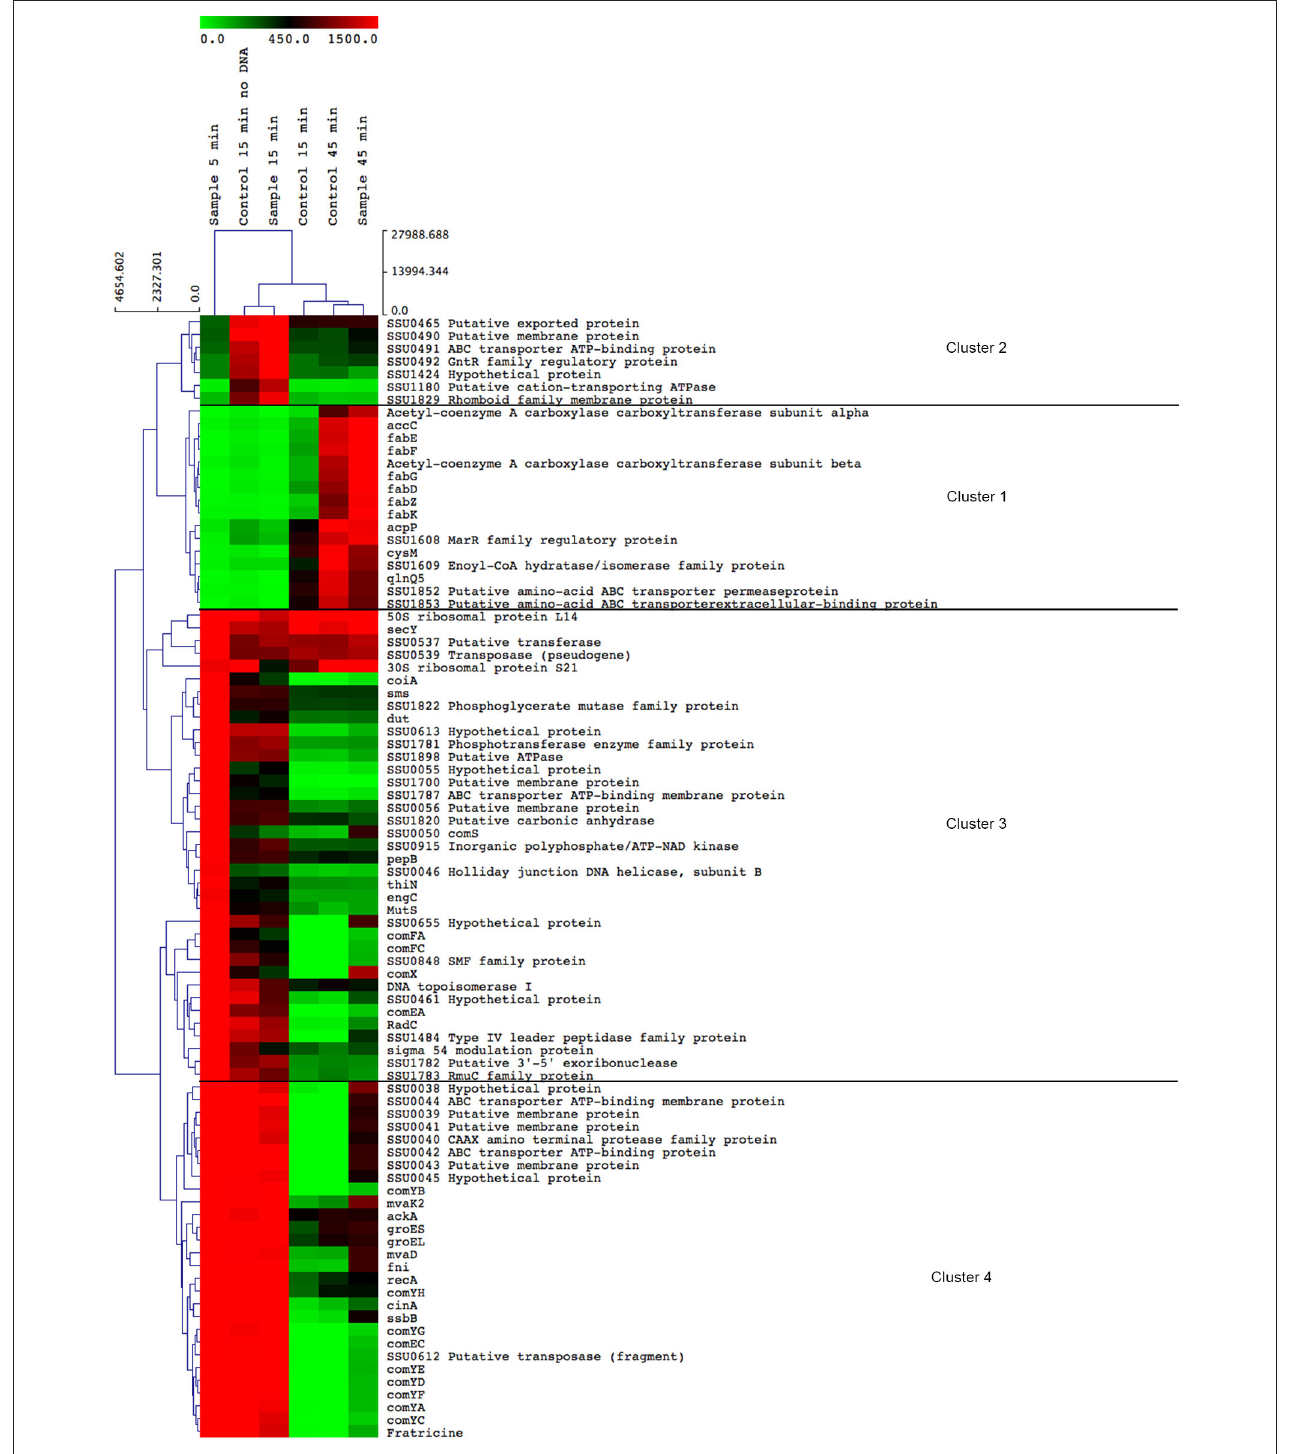
FIGURE 1 | Heatmap displaying the most differentially expressed genes in S. suis during competence. Genes were filtered using Cluster 3.0 (See Methods) and were clustered using average linkage and Euclidian distance using MultiExperiment Viewer (MeV, see Methods). The color scale at the top depicts the normalized, unlogged expression values of the genes indicated on the right. The heatmap colors represent gene expression levels from the lowest value (zero, light green) to the highest level ( ∼ 3000, bright red). To not lose resolution of intermediary expression levels, a highest cut-off value of 1500 was applied. The time at which bacterial samples were rapidly centrifuged and suspended in RNAprotect buffer is indicated above each column. “Control” indicates bacterial cultures to which no inducing peptide was added. “No DNA” indicates that no transforming DNA was added together with the competence inducing peptide.